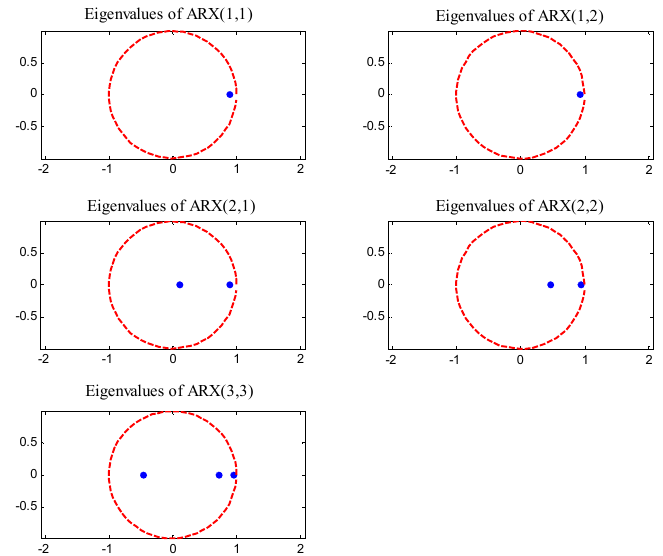
Figure 14. The root distribution of the AR part of five ARX